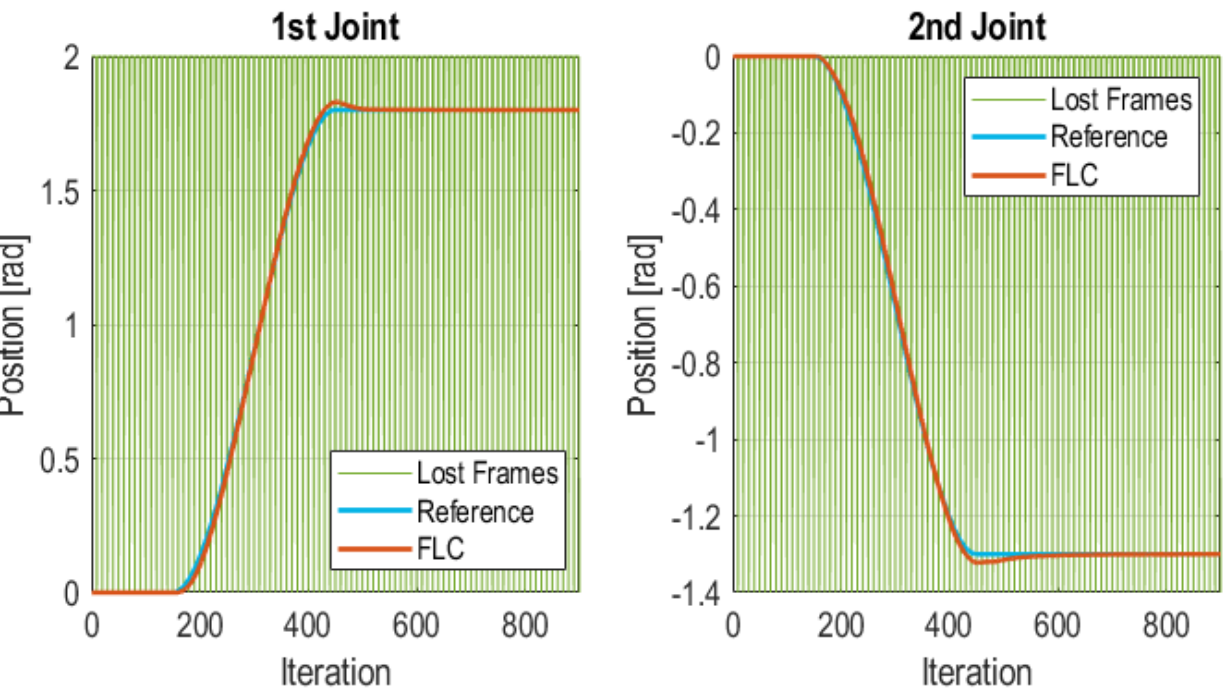
Figure 12. FLC for a cubic trajectory with sporadic communication errors.